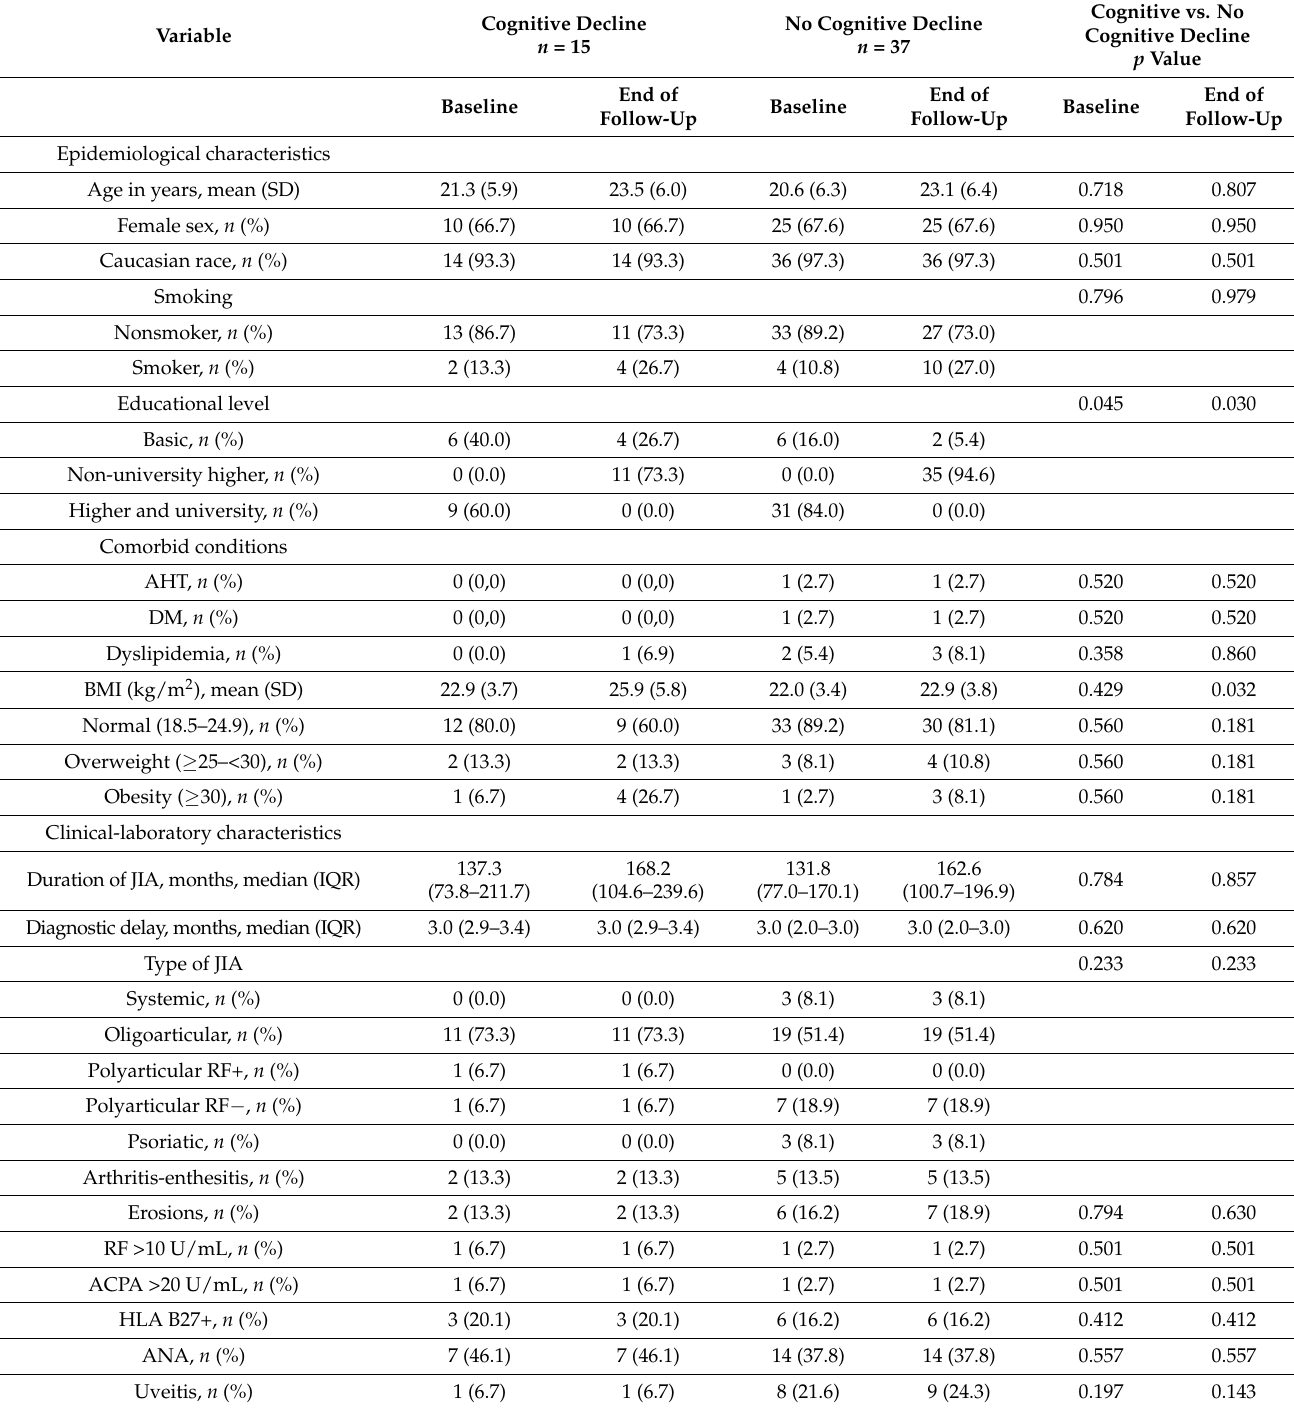
Table 3. Characteristics of patients with JIA at baseline and the end of follow-up according to cognitive